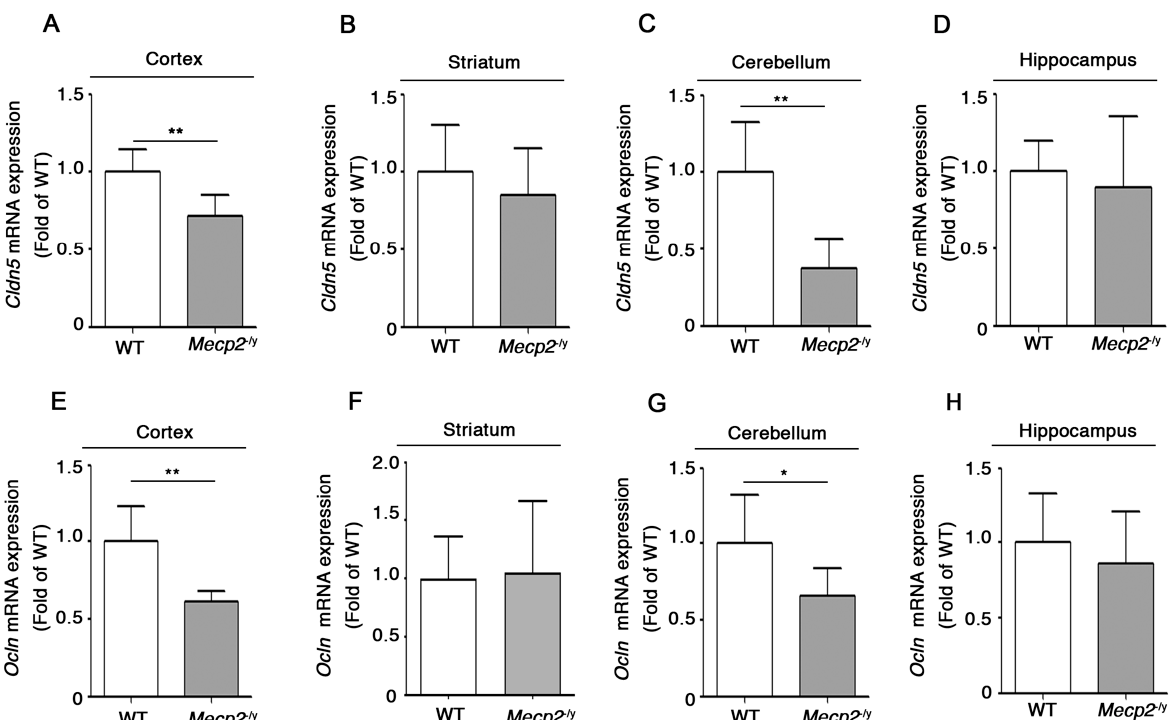
Figure 3. Expression of Cldn5 and Ocln mRNAs is defective in brain tissues of Mecp2 -/y mice. qPCR analysis of Cldn5 and Ocln in cortex ( A , E ), striatum ( B , F ), cerebellum ( C , G ), and hippocampus ( D , H ) of Mecp2 -/y mice and age-matched WT littermates. Data were normalized to Gapdh. Values are represented as mean ± SD. N = 6 for each group of mice. *, p < 0.05; **, p < 0.01 (two-tailed unpaired t test).